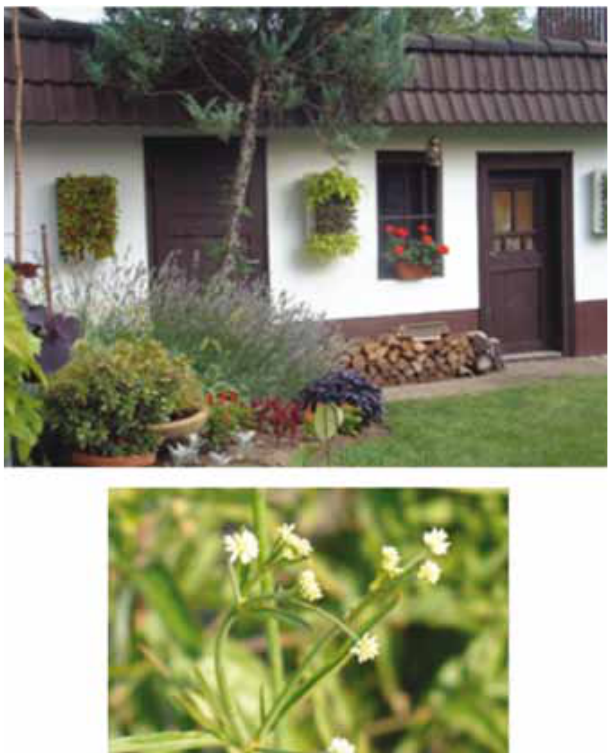
Figure 10; 11: Design and construction of high aesthetic appearance plant live-picture modules